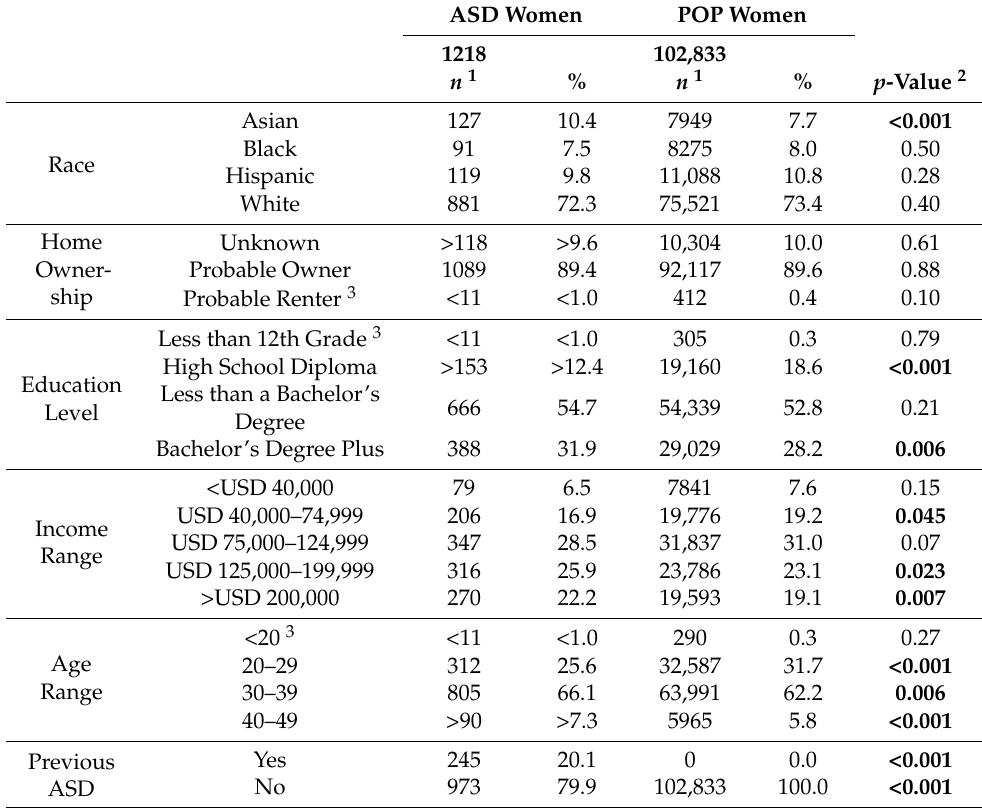
Table 3. Sociodemographic Data on Women Cohorts.